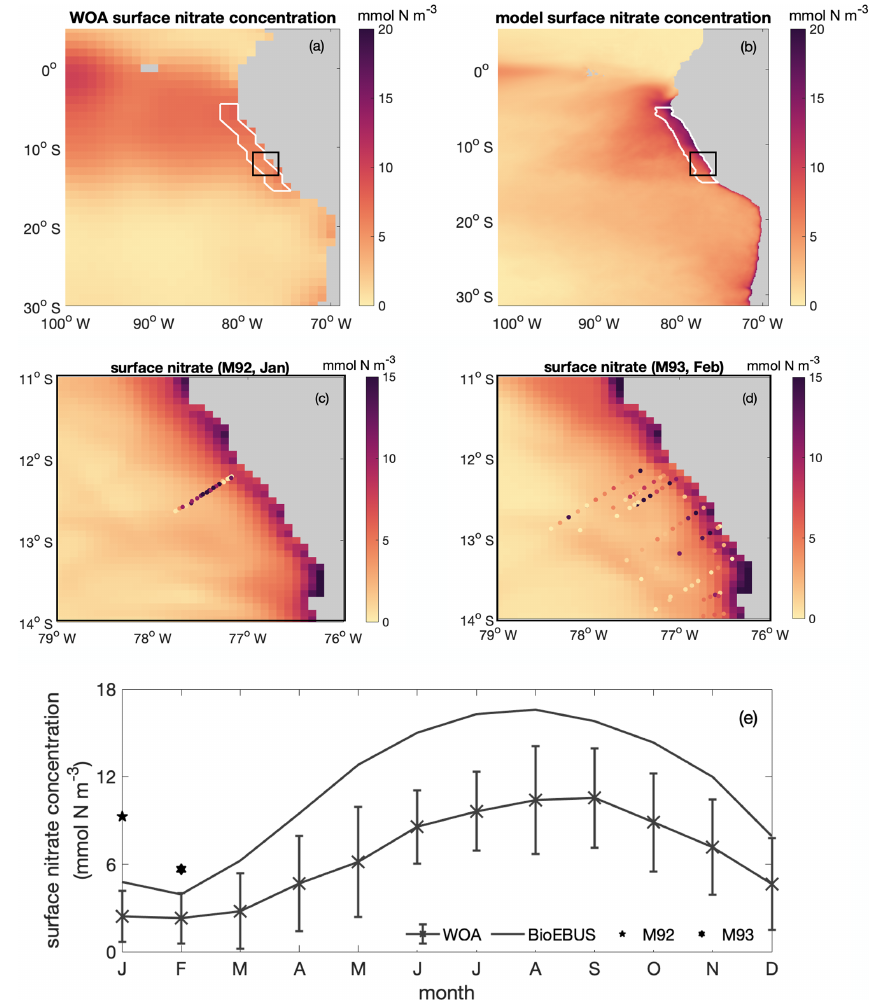
Figure B2. Spatial distribution of surface nitrate concentration based on (a) WOA and (b) CROCO–BioEBUS, (c) January and (d) February as simulated by CROCO–BioEBUS. Dots indicate measurements from the cruises M92 (January) and M93 (February). (e) Seasonal cycle of surface nitrate concentration from WOA (cross), CROCO–BioEBUS (line) and cruises (pentagram, hexagram) within the focus region. White lines highlight the focus region. The black box indicates the maps of (c) – (d)